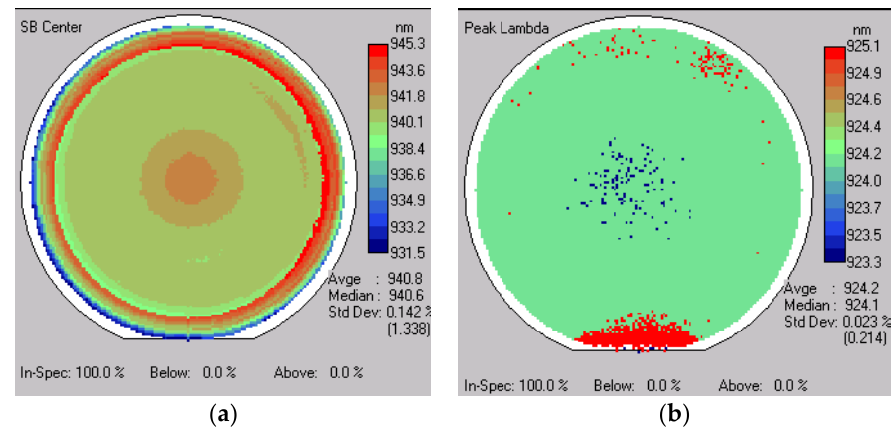
Figure 9. Distribution map of ( a ) DBR (Distributed Bragg Reflector) stop-band center and ( b ) quantum well wavelength over the 6-inch wafer (5 mm edge exclusion).